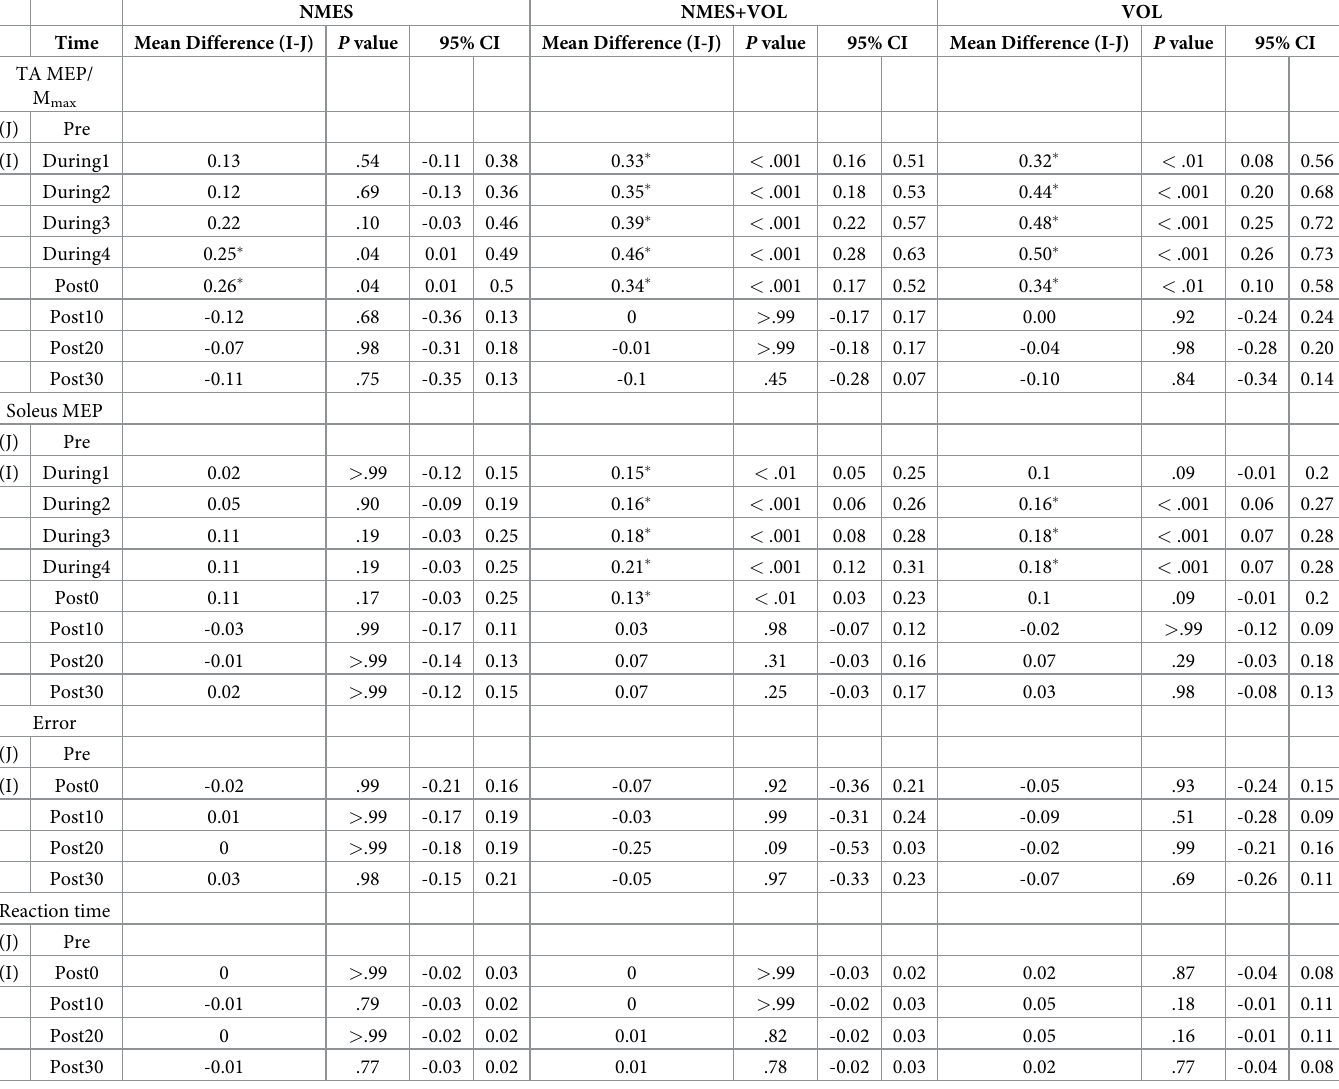
Table 2. Results of Dunnett’s test for the TA MEP/M max differences between Pre and other time points for each